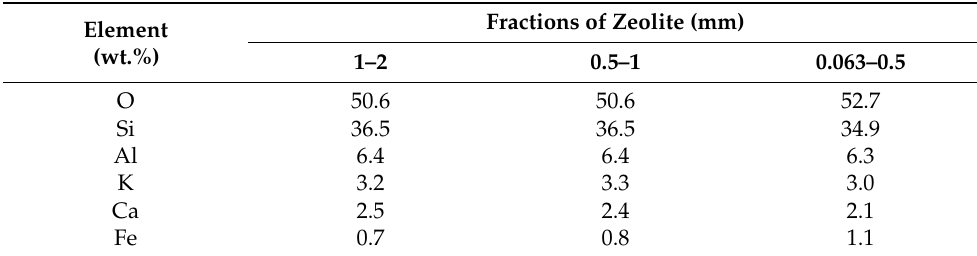
Figure 2. Microstructure of different zeolite fractions observed using SEM. Table 3. Elemental composition of zeolite fractions obtained using EDS.